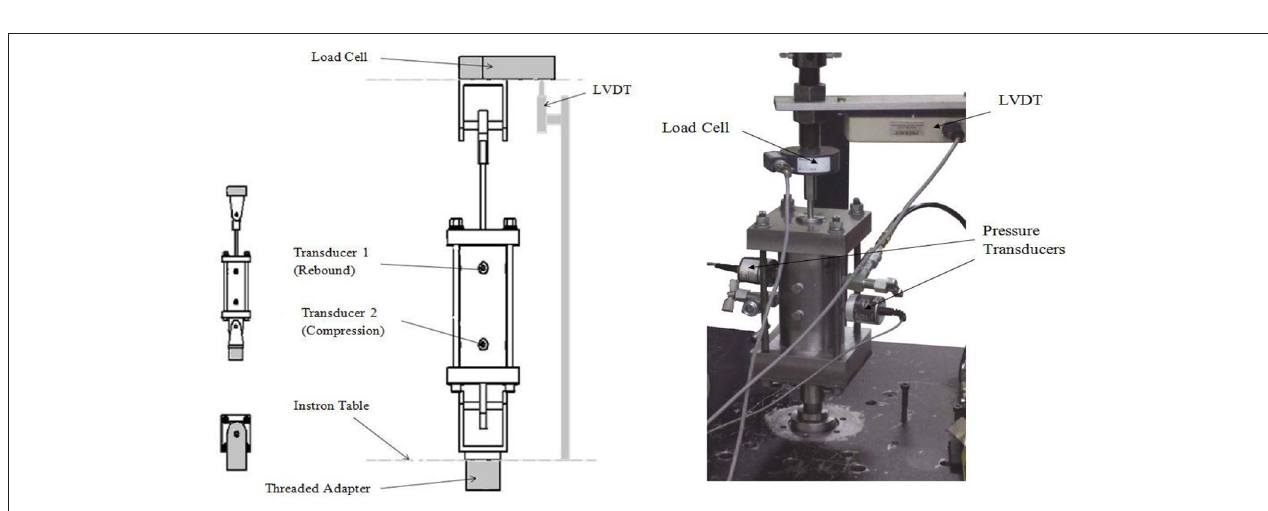
FIGURE 6 | Schematic and photograph of quasistatic test setup showing the placement of the transducers, LVDT, load cell, and attachment to the screw-drive machine.